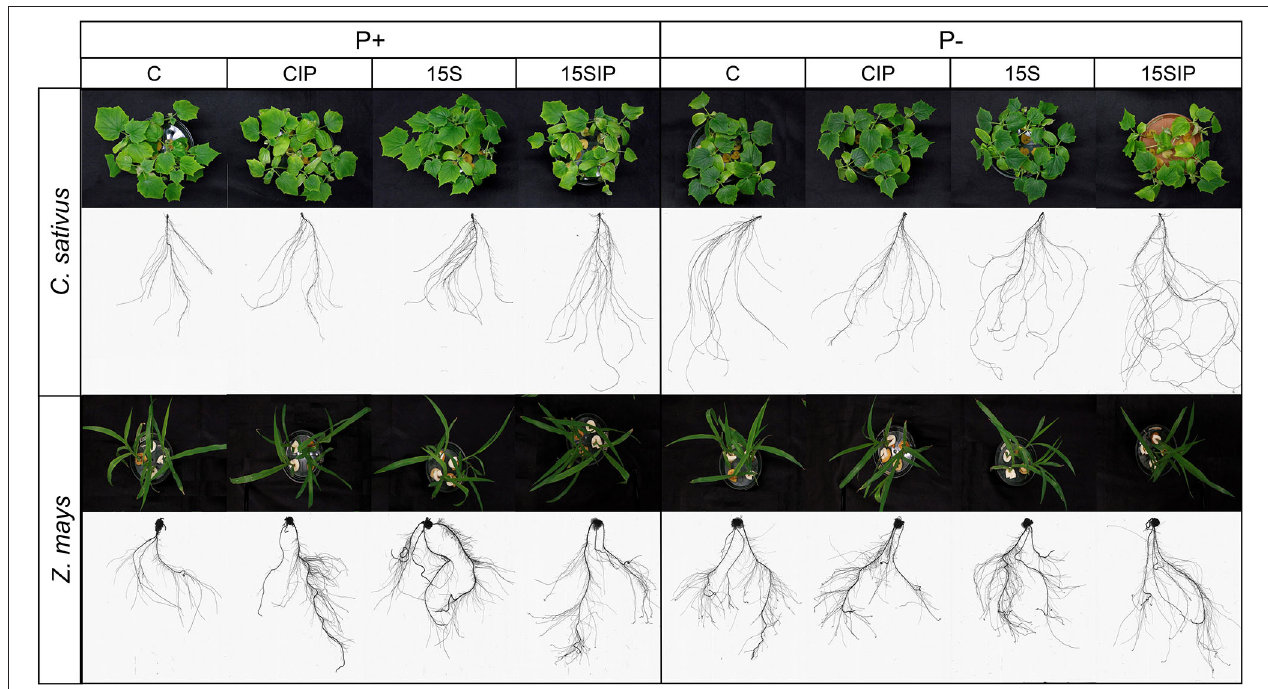
FIGURE 2 | Shoot and root apparatus of cucumber ( C. sativu s) and maize ( Z. mays ) plants in response to a factorial experiment with two P fertilization levels (P + , NS supplemented with 0.1mM of KH 2 PO 4 ; P–, NS non-supplemented with KH 2 PO 4 ) and four biostimulant treatments [C, uninoculated control; CIP, uninoculated control with the insoluble phosphate Ca 3 (PO 4 ) 2 ; 15S, inoculated with the PGPB Enterobacter 15S; 15SIP, inoculated with the PGPB Enterobacter 15S plus the insoluble phosphate Ca 3 (PO 4 ) 2